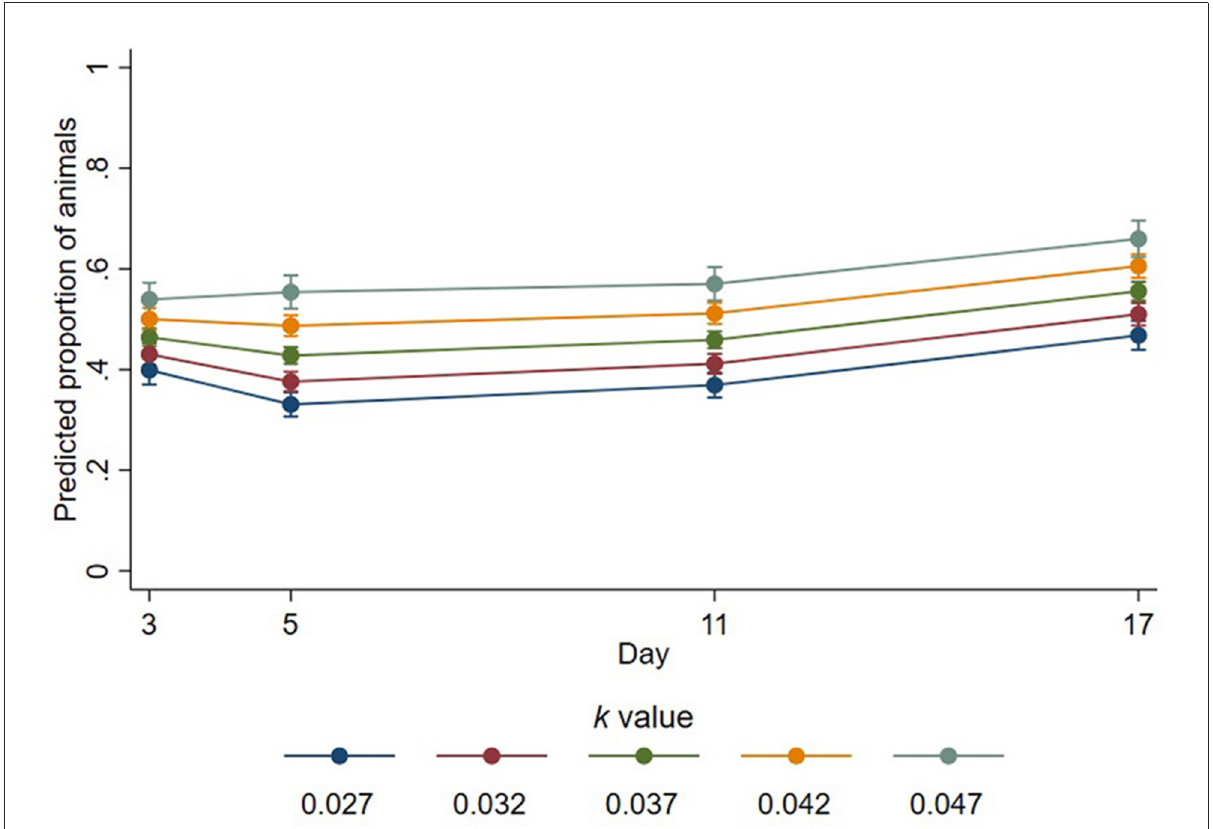
FIGURE2 Predicted proportions of lying animals that had outstretched legs at different k -values across days. Error bars represent 95% confidence intervals of predicted proportions. Predicted proportions were calculated as predicted numbers divided by the average number of sheep lying at each time point